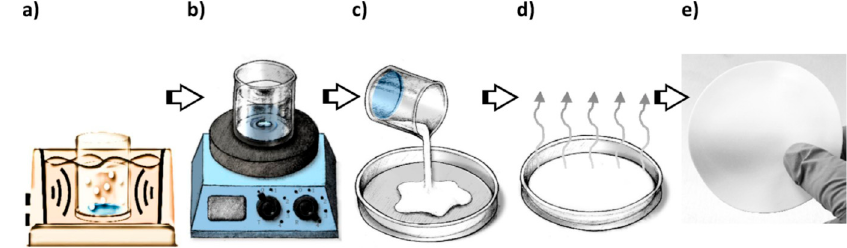
Figure 1. Schematic representation of the preparation of TiO 2 /poly(vinylidenefluoride–trifluoroethylene) (TiO 2 /PVDF-TrFE) nanocomposite photocatalytic membranes (PMs) by solvent casting; ( a ) ultrasonic bath of N , N -dimethylformamide (DMF) and TiO 2 nanoparticles (NPs); ( b ) magnetic stirring of DMF, TiO 2 NPs, and PVDF-TrFE; ( c ) pouring of the solution on a glass support; ( d ) solvent evaporation at room temperature; and, ( e ) membrane after complete evaporation of the solvent (Aoudjit et al. [42]).